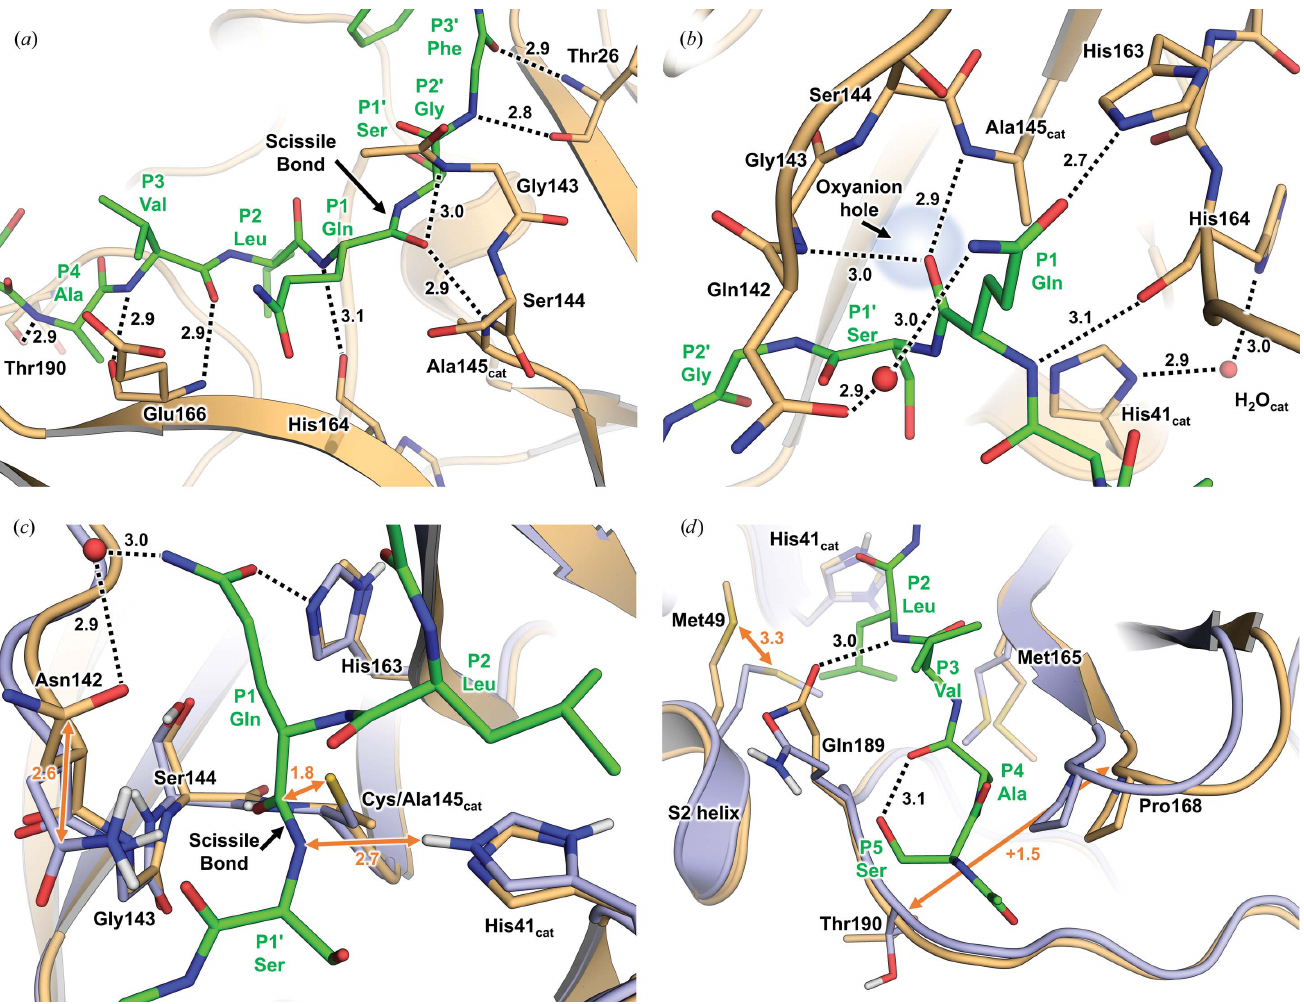
Figure 2 M pro/C145A –substrate interactions for induced fit of substrate. ( a ) Main-chain hydrogen-bond interactions between M pro and the peptide substrate (shown as orange and green C atoms, respectively). Hydrogen bonds are shown as dotted lines. Distances are in A˚ . ( b ) Hydrogen-bond interactions between peptide P1 Gln with the S1 subsite and the catalytic site. Water molecules are shown as red spheres. ( c ) Superposition of M pro/C145A –substrate with the substrate-free M pro neutron crystal structure (light blue; PDB entry 7jun) showing the scissile bond in relation to the catalytic Cys145–His41 zwitterion. Superposition was by a least-squares fit to C (cid:3) atoms of protomer A . ( d ) Induced fit of M pro/C145A to the peptide substrate by the rearrangements of side chains in the S2 and S4